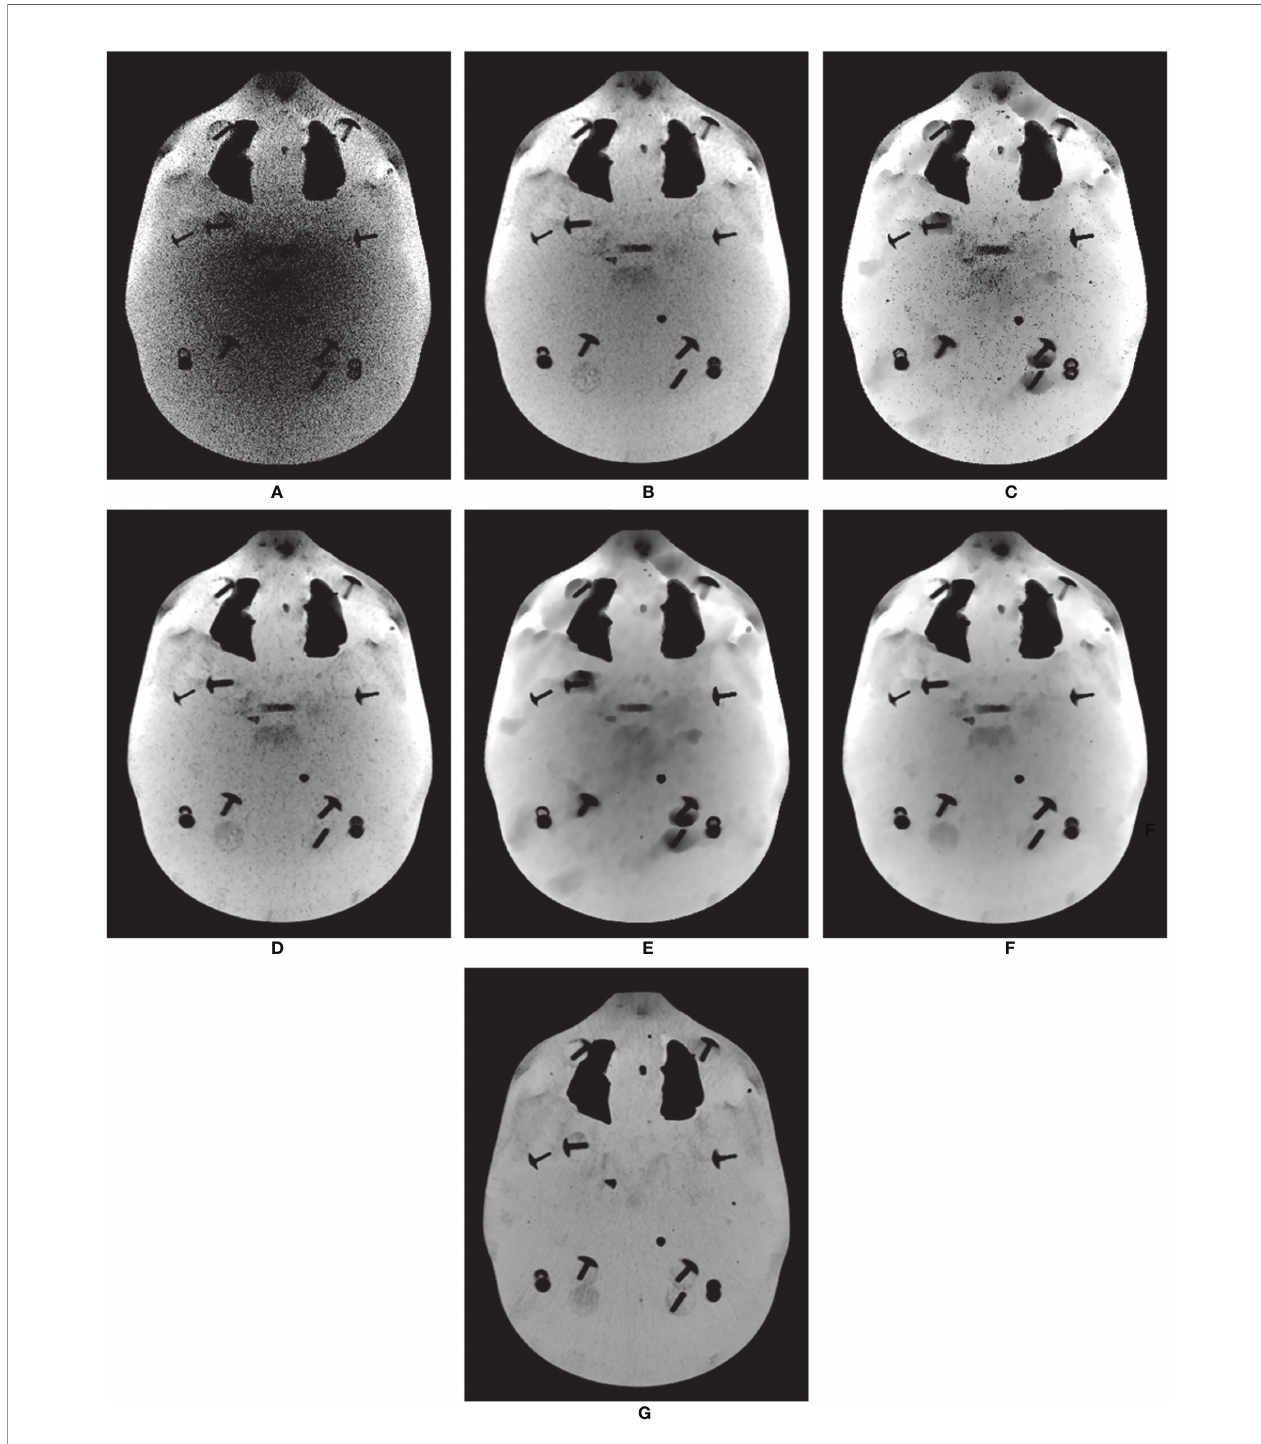
FIGURE 5 | Comparison of minimum intensity projections (MinIPs) of CBCT images generated by applying the analytical reconstruction algorithm based on (A) PDB, (B) RDB, (C) PDB followed by NLTV, (D) RDB followed by NLTV, (E) PDB followed by MI-NLTV, and (F) RDB followed by MI-NLTV using the anthropomorphic head-and-neck phantom. (G) Benchmark image. These images are displayed at the window settings of (width = 750, level = 0)